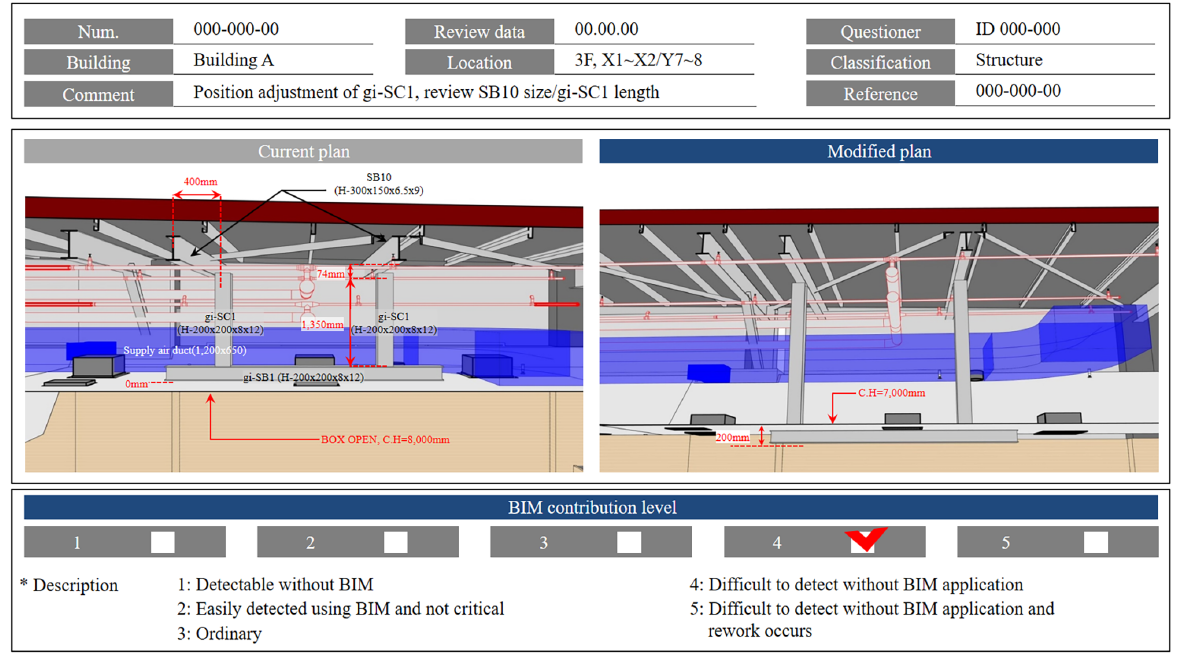
Figure 2. Example of a questionnaire for the BIM contribution level Table 1. c r value by level of the BIM contribution